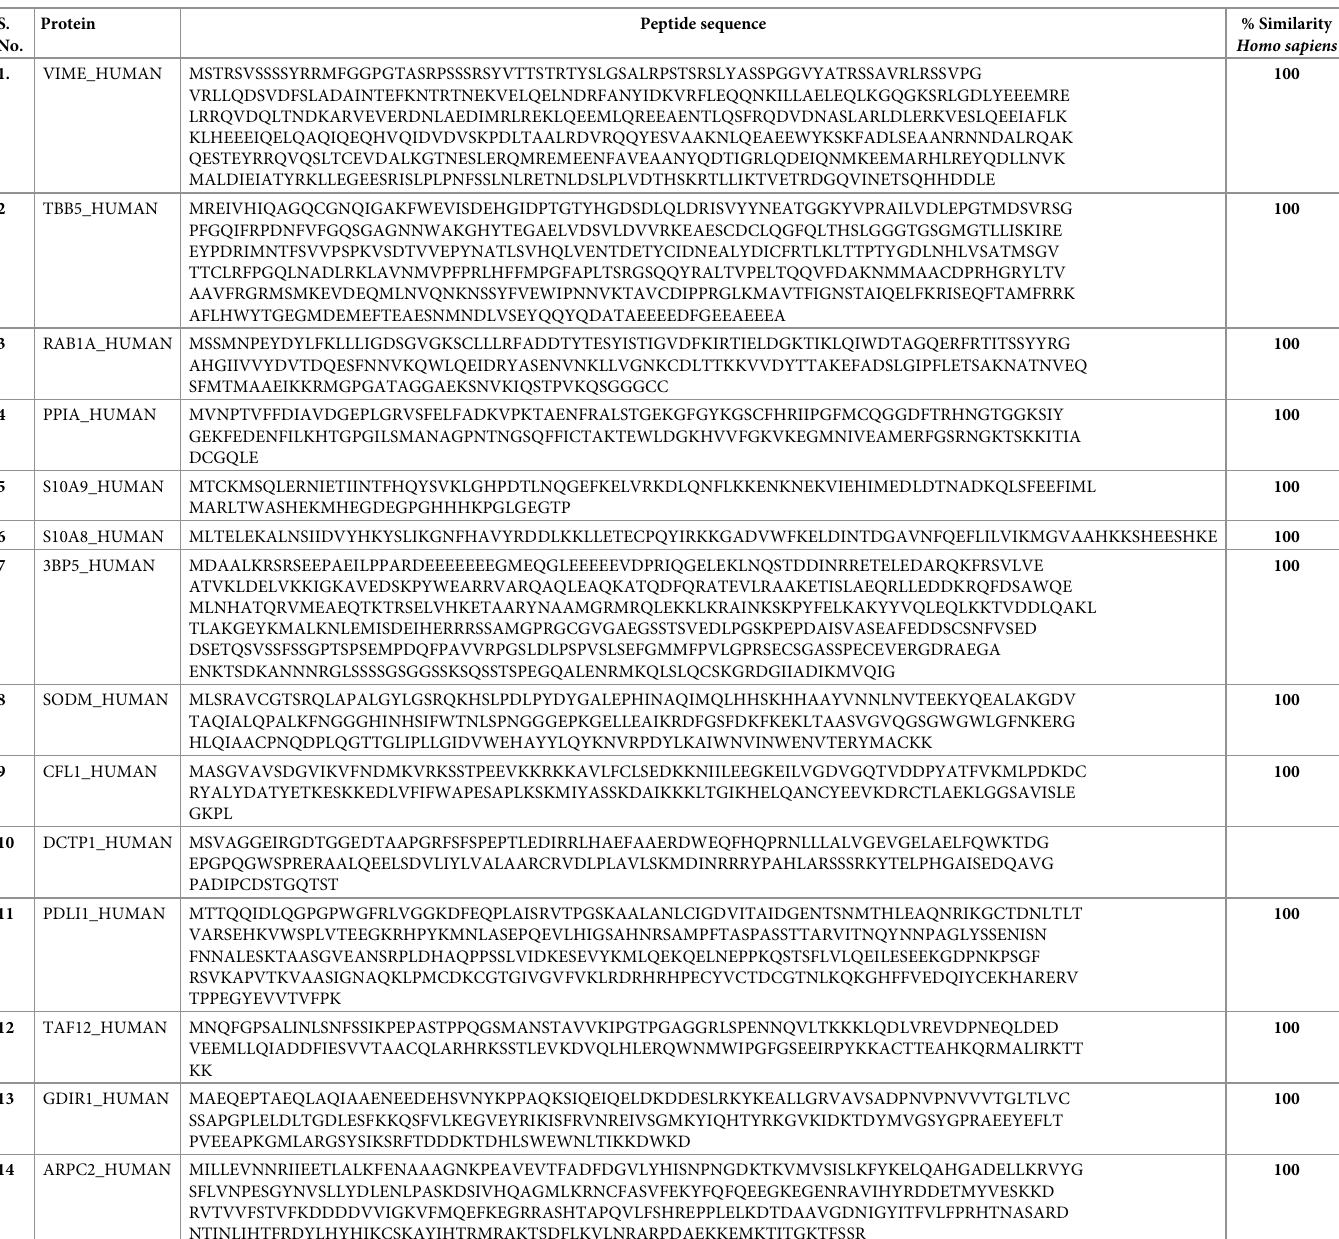
RVTVVFSTVFKDDDDVVIGKVFMQEFKEGRRASHTAPQVLFSHREPPLELKDTDAAVGDNIGYITFVLFPRHTNASARD